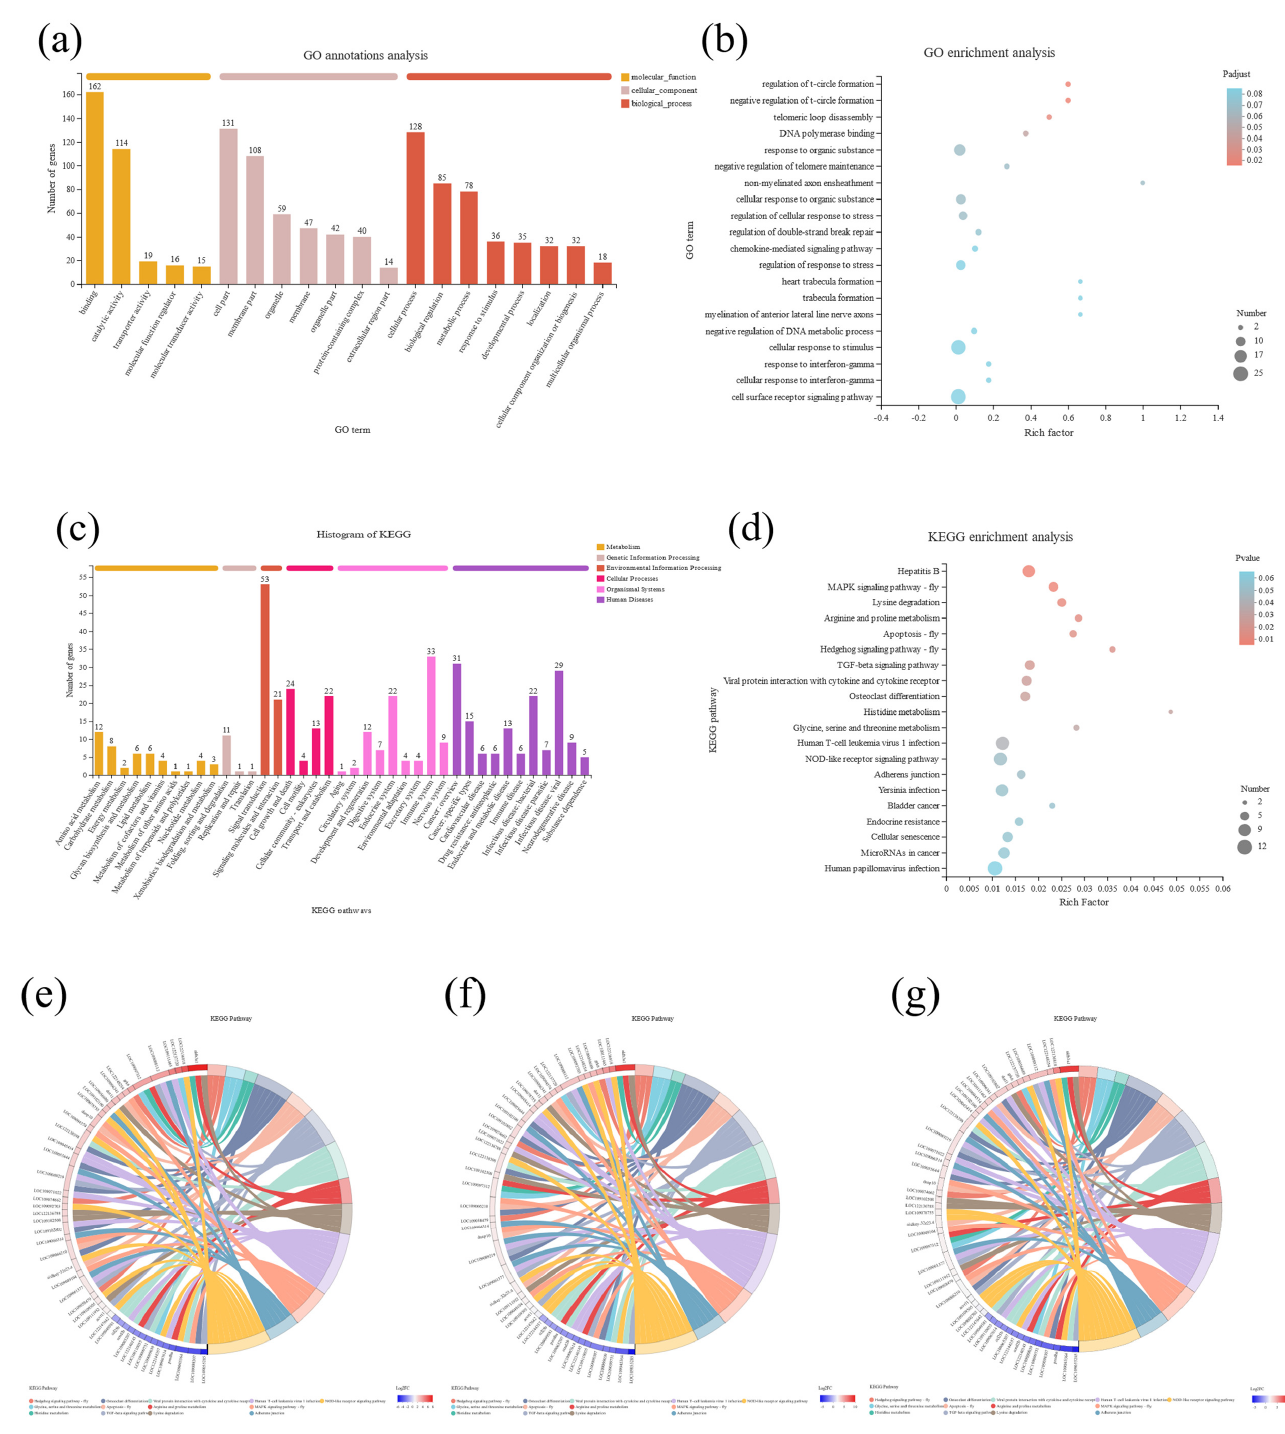
Figure 5. GO and KEGG analysis of DEGs from C. carpio fed different levels of KM: ( a ) GO annotation analysis of DEGs; ( b ) GO annotation enrichment analysis of DEGs; ( c ) KEGG analysis of DEGs; ( d ) KEGG enrichment analysis of DEGs; DEGs corresponding to the KEGG pathway in groups ( e ) 0.2, ( f ) 2, and ( g ) 20 mg/kg.